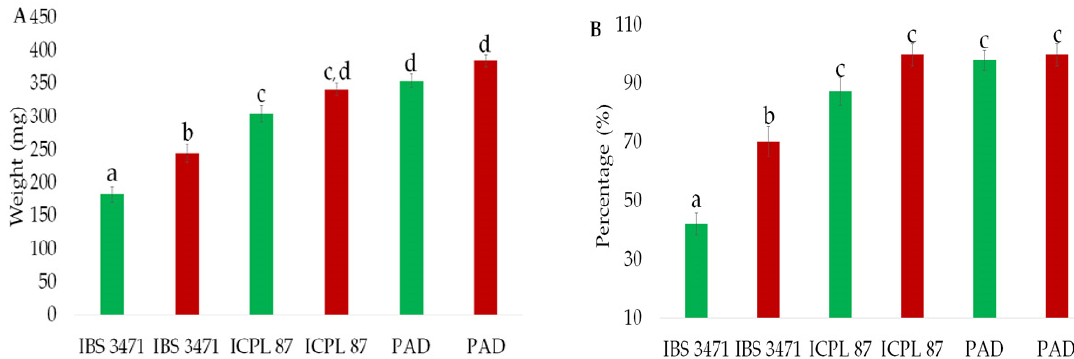
Figure 4. E ff ect of heated and non-heated artificial diet with lyophilised leaf powder on weight (mg) and pupation (%) of H. armigera larvae. ( A ) Average larval weight of H. armigera fed on an artificial diet supplemented with lyophilised leaf powder of IBS 3471 and ICPL 87 on a non-heated diet (green bars) and heated diet (red bars). ( B ) Percentage of pupated H. armigera larvae fed on a non-heated diet (green bars) and heated diet (red bars) artificial diet with lyophilised leaf powder by day 11. Values labelled with different letters are significantly different at p < 0.01 (Tukey’s HSD test). All data are means ± standard errors ( n = 64). PAD: plain artificial diet.